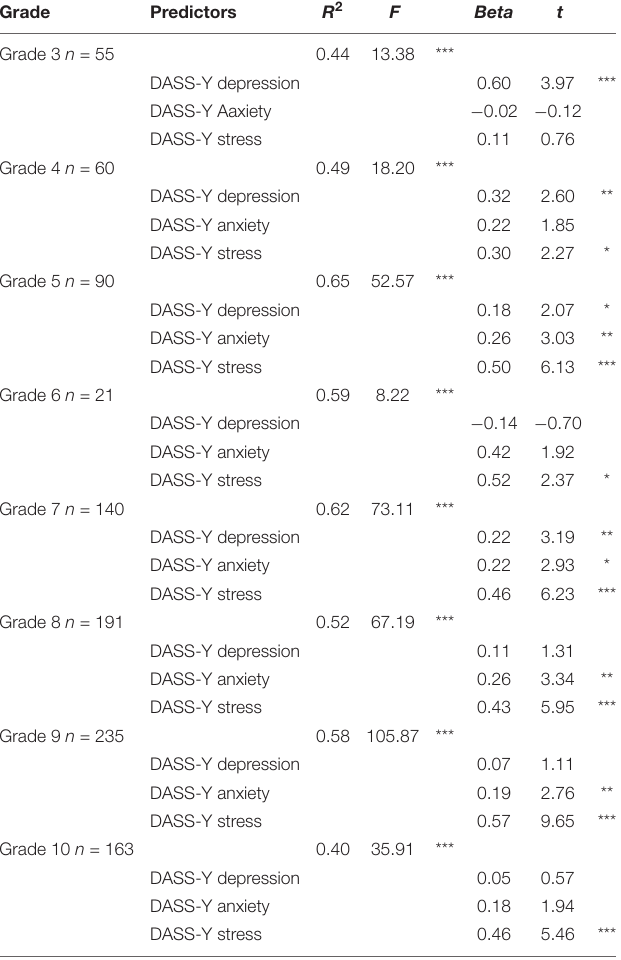
TABLE 8 | Simultaneous multiple regression analyses predicting total scores on the PSWQ-C in each school grade separately.